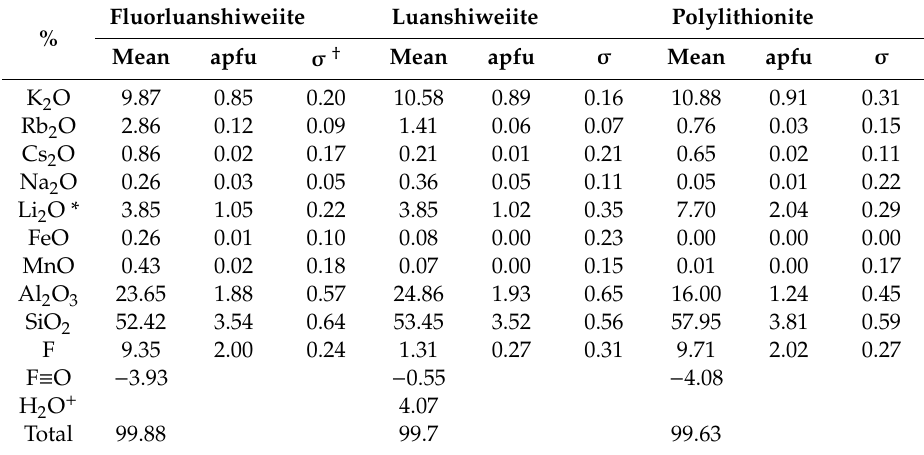
Table1. Chemicalcomposition(wt. %)offluorluanshiweiiteandotherlepidolitespeciesinnanyangshan LCT deposit.